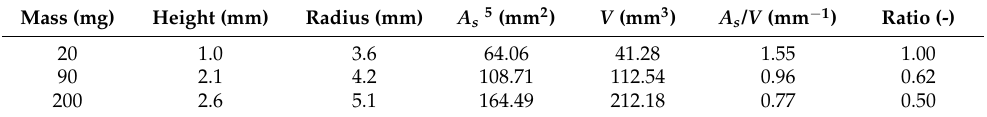
Table 6. Average DSC sample